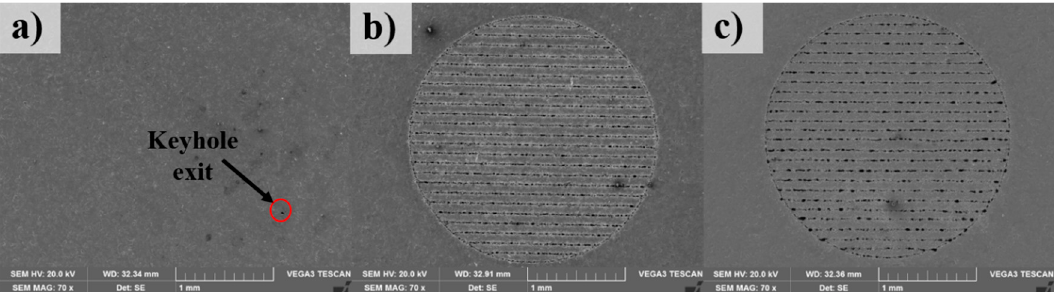
Figure 4. SEM image of the bottom view ( a ) 10 W, ( b ) 15 W and ( c ) 20 W.